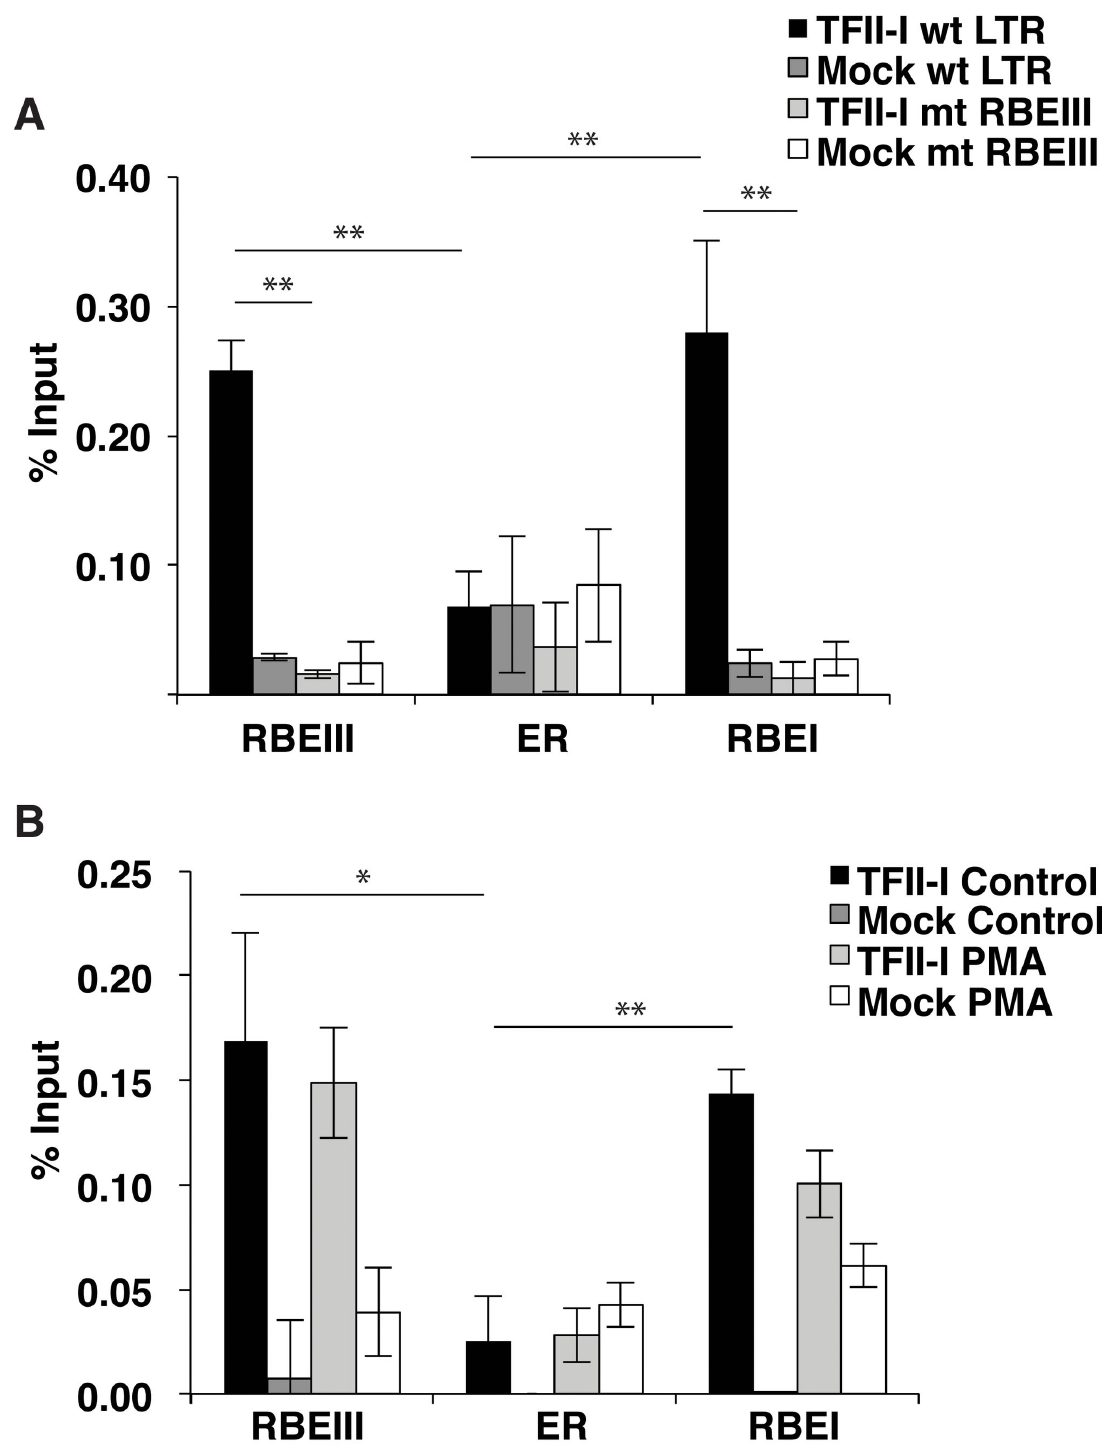
Figure 5. TFII-I binds to RBEIII constitutively. Panel A : A representative pool of Jurkat-tat cells infected with the wild type (solid bars) and RBEIII/YY1 mutant (open bars) reporter virus were used for ChIP analysis with TFII-I antibody. Panel B : A representative clone of Jurkat-tat cells infected with the wild type reporter virus was induced with PMA or left untreated (control) and used for ChIP analysis with α-TFII-I antibodies, and the primers specific for RBEIII, the enhancer region (ER) and the RBEI site. * Represents P values ≤ 0.05, ** represents P values ≤ 0.01. doi: 10.1371/journal.pone.0077052.g005 PLOS ONE |